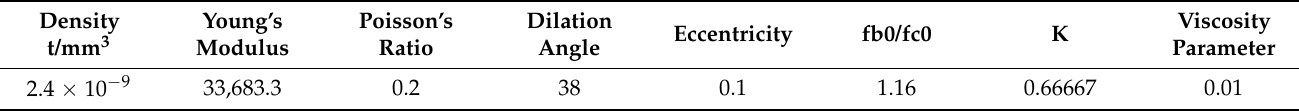
Table 6. Concrete basic parameters.